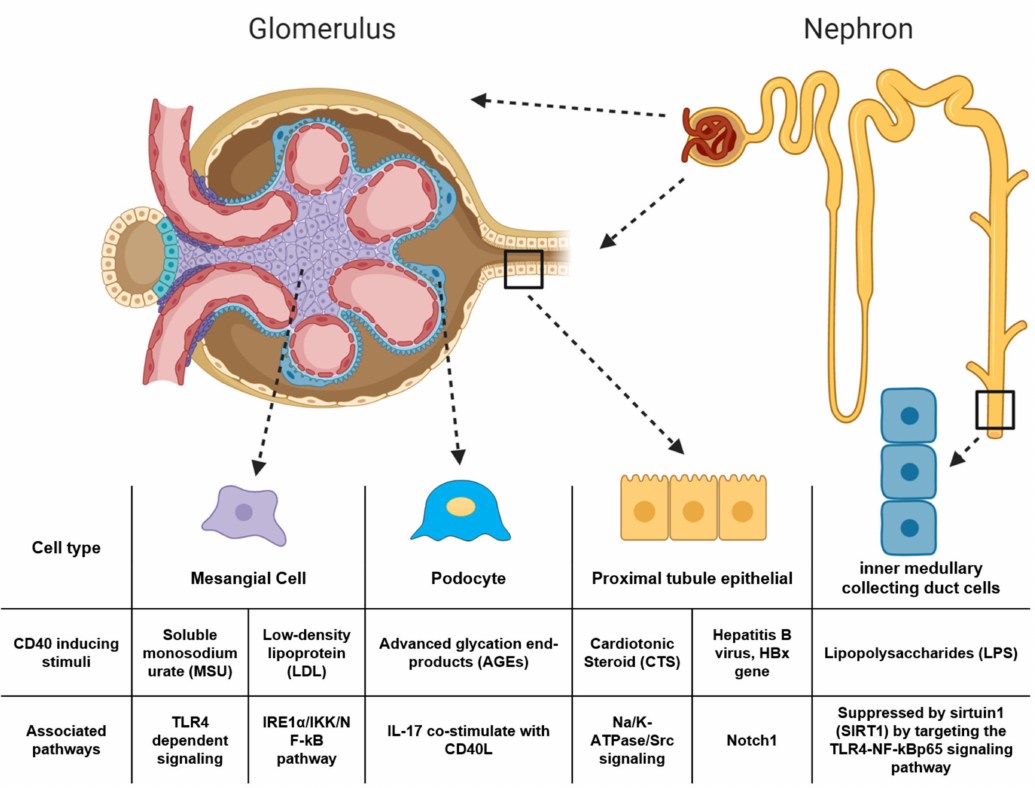
Figure 2. Summary of the known inducers of CD40 in mesangial cells [106,107], podocytes [42], proximal tubule epithelial cells [99,100,104], and the inner medullary collecting duct cells [112,113]. (Figure created with